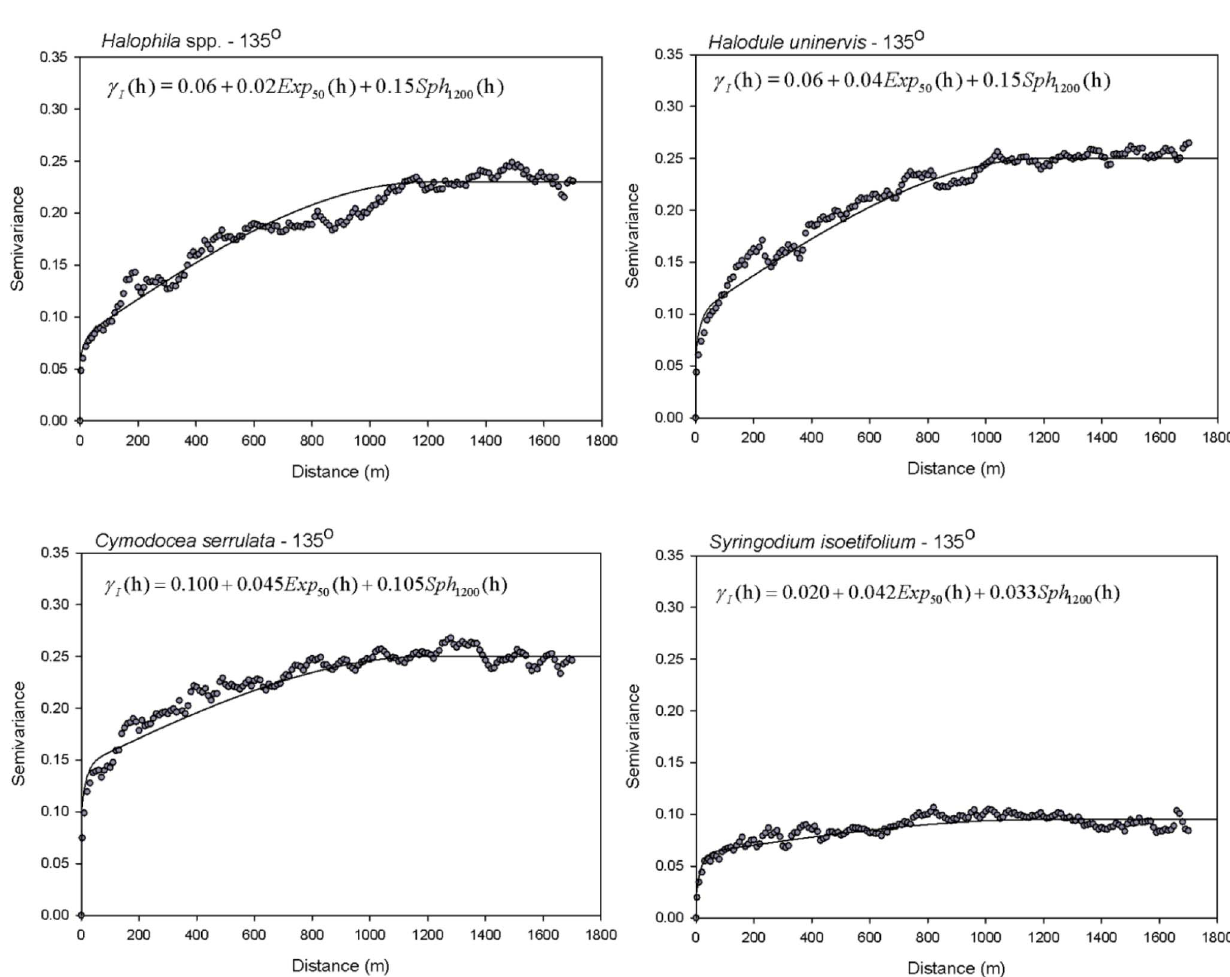
Figure 4. Sample variograms (dots) and the fitted Linear Model of Coregionalization (solid lines) of seagrass species presence/ absence in the along-shore direction (135 u ) in Pulau Tinggi, Malaysia. Sample variograms are displayed with a lag of 10 m and a tolerance of 5 m. doi:10.1371/journal.pone.0086782.g004 PLOS ONE |